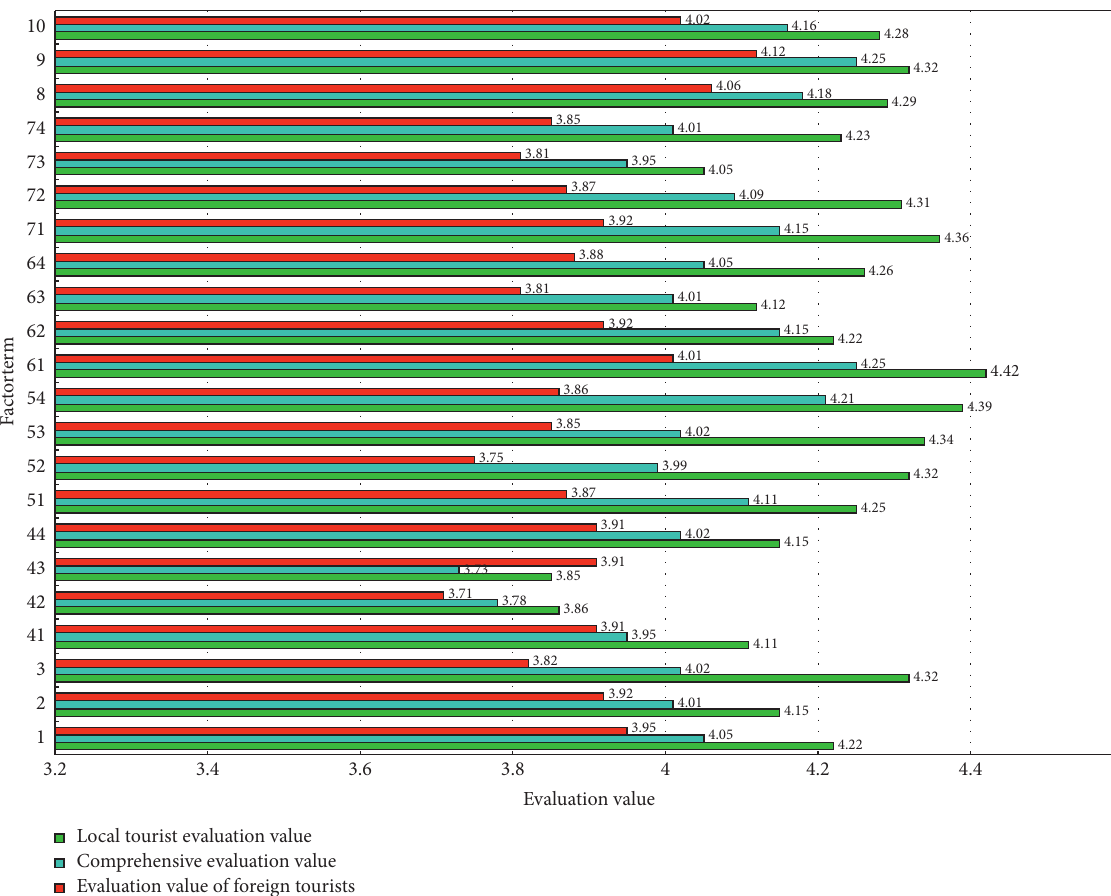
Figure 7: Comparison of evaluation values of different